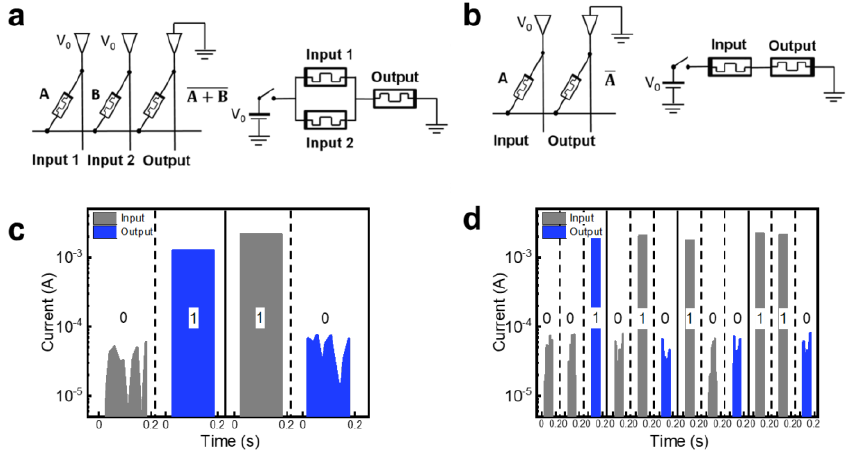
Figure 3. MAGIC logic gates. ( a ) NOT logic gate within memristor crossbar array and its equivalent circuit. ( b ) NOR logic gate within memristor crossbar array and its equivalent circuit. ( c ) Experimental result of NOT logic gate and ( d ) NOR logic gate of GO-based memristor. Note that the resulting values of the four NOR logic gates are the values for the combination of the four input values, and the MAGIC logic was implemented by simultaneously applying the voltage V 0 to the two input values instead of